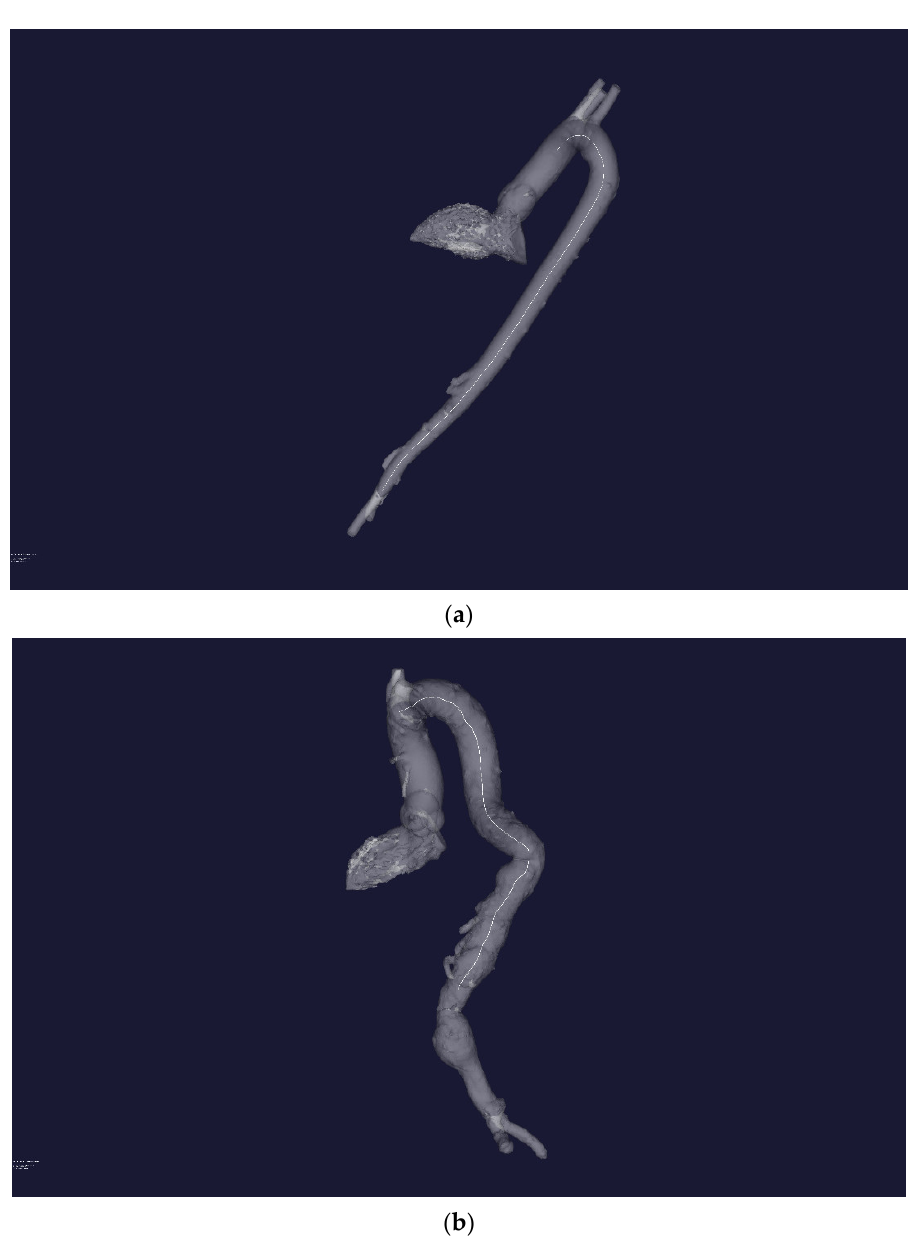
Figure 3. ( a ) Three-dimensional STL—reconstruction of the flow channel of the aorta without severe pathology. A central line is built inside the flow channel. ( b ) Three-dimensional STL—reconstruction of the flow channel of the aorta with severe pathology of the distal sections. A central line is built inside the flow channel.